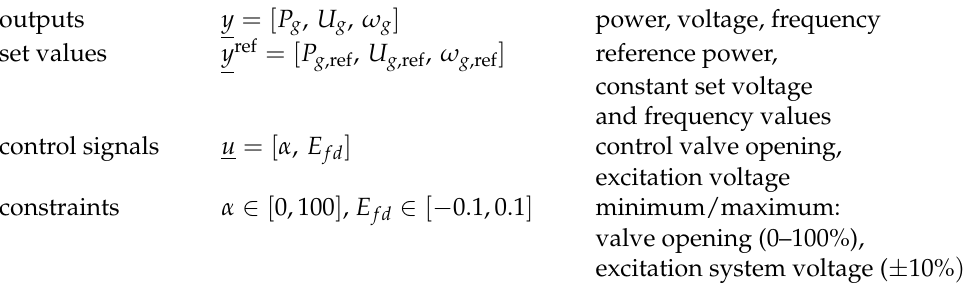
Table 1. Integral quality indices.